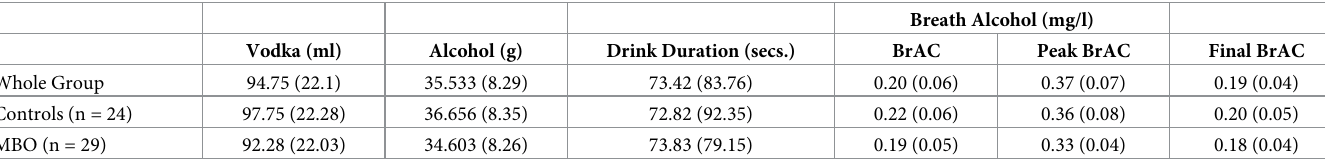
Table 2. Alcohol dose, drinking time, and mean